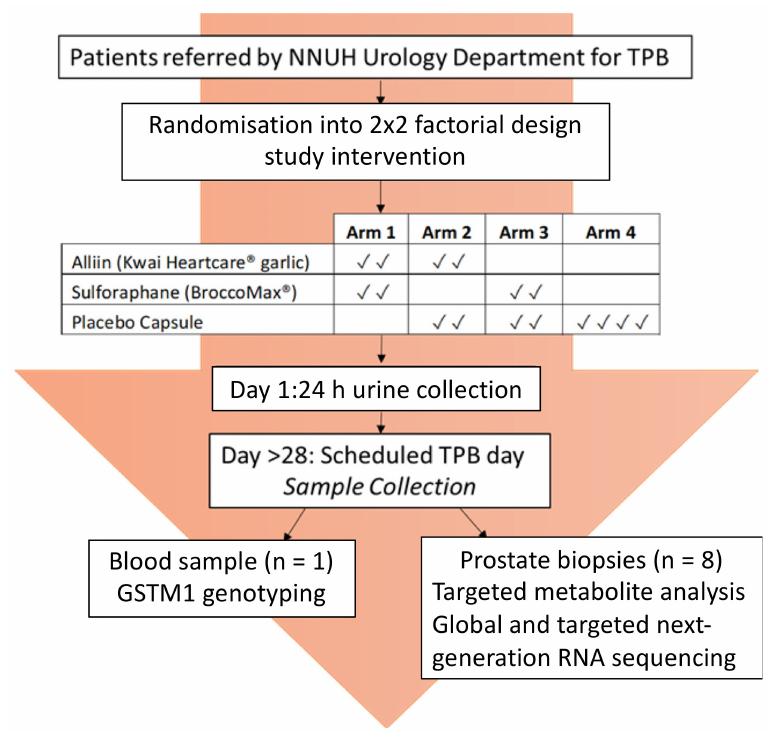
Figure 1. Norfolk ADaPt Study